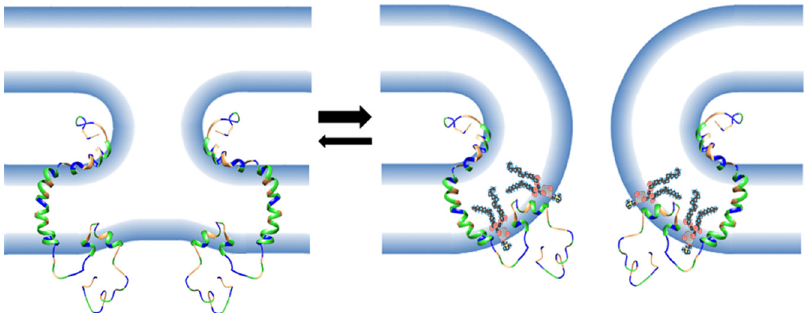
Fig 10. Model of the role of the FLiPS motif in membrane fusion. Depicted is a FAST protein structure based on composite NMR structures of p14 ectodomain and transmembrane domain conformers, and a p15 endodomain FLiPS conformer. Linker regions and the extended C-terminal tail (which is intrinsically disordered) are modelled as unstructured loops. Residues are colour-coded: green, hydrophobic; blue, polar/ charged; orange, neutral. Fusion peptide motifs in FAST protein ectodomains are predicted to combine with essential residues in the external interfacial region of the transmembrane domain [34] to alter membrane curvature leading to dimple formation and merger of outer bilayer leaflets creating a presumed hemifusion intermediate (left). Negative curvature stresses in the outer monolayer create corresponding positive curvature stresses in the inner monolayer, rendering this transient intermediate energetically unfavorable and likely to revert to two planar bilayers. However, FLiPS partitioning into regions of increasing positive curvature, such as those in the inner monolayer at the base of the stalk-like hemifusion intermediate, would stabilize curvature stresses and promote further positive curvature making the forward reaction to pore formation (right) a more energetically favorable means to resolve the unstable hemifusion intermediate curvature. POPC molecules show insertion of the FLiPS into a hydrophobic defect generated by curvature stresses forcing apart lipid